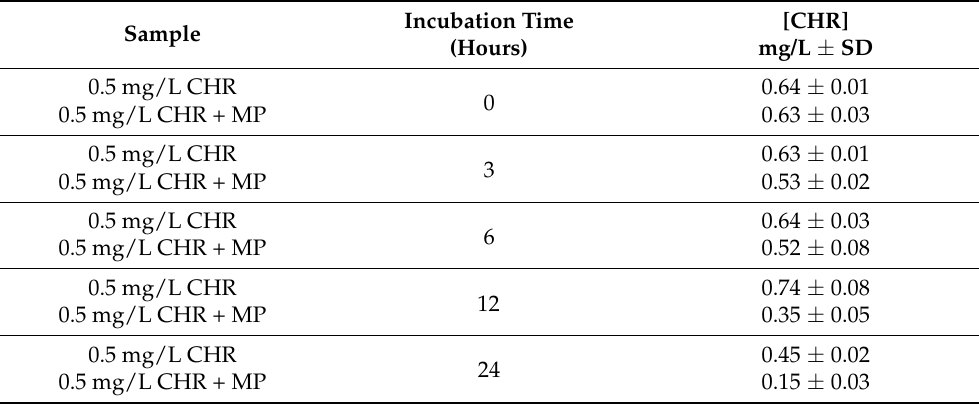
Table 1. Chrysene (CHR) concentrations measured using GC-MS in filtered water after incubation of 0.5 mg of 3- µ m MP in 0.5 mg/L CHR solution and in a CHR ‘control’ solution having the same CHR nominal concentration and incubated for the same time intervals in the absence of MP. Data are expressed as mean ± SD ( n =